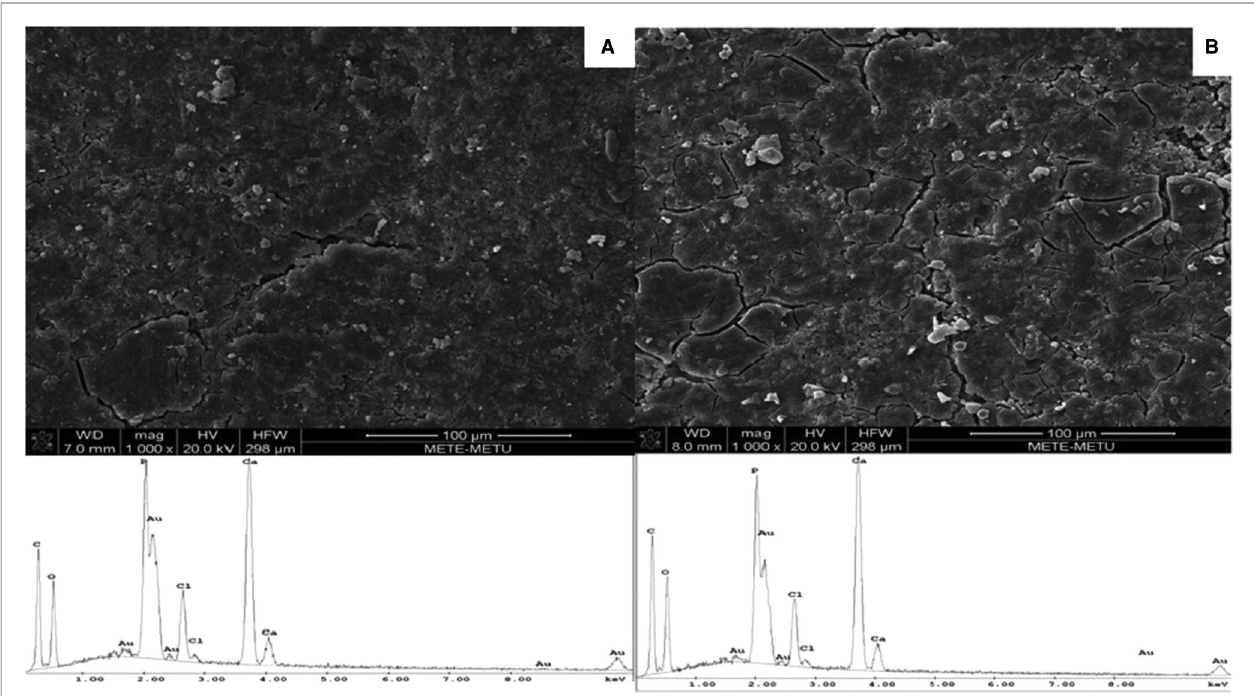
FIGURE 2 | SEM micrographs (1,000× magni fi cation) and EDS spectra of vancomycin containing ( A ) PDLLA/ β -TCP and ( B ) PLGA/ β -TCP composites. PDLLA, poly ( D , L -lactide); PLGA, poly( D , L -lactide-co-glycolide); β -TCP, beta-tricalcium phosphate; EDS, energy-dispersive spectrometry; SEM, scanning electron